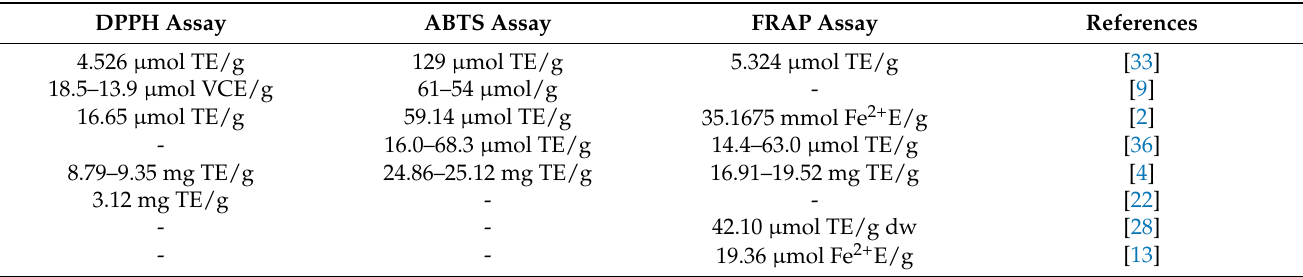
Table 3. Antioxidant and antiradical activities of goji berries according to different